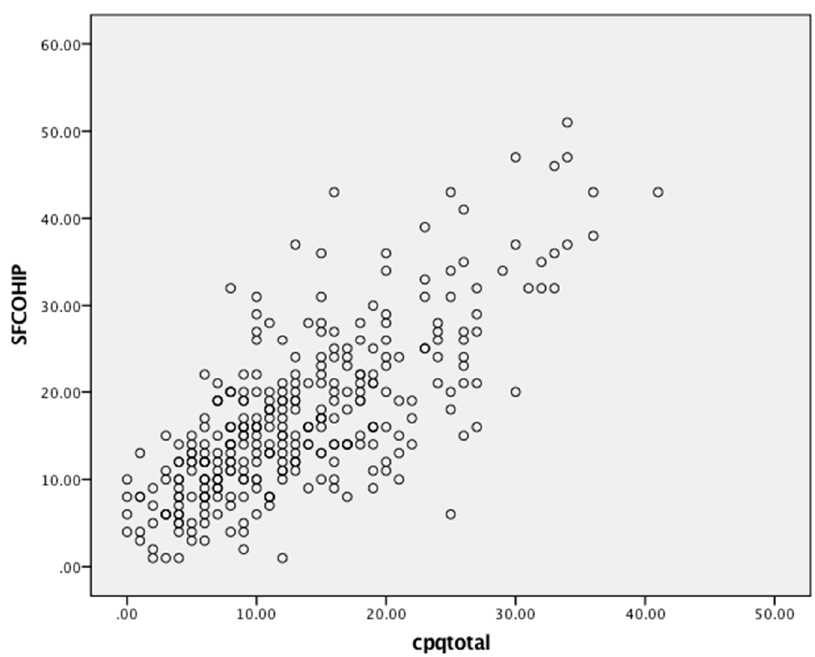
Figure 1. Scatterplot of baseline COHIP-SF and CPQ 11-14 scale scores.